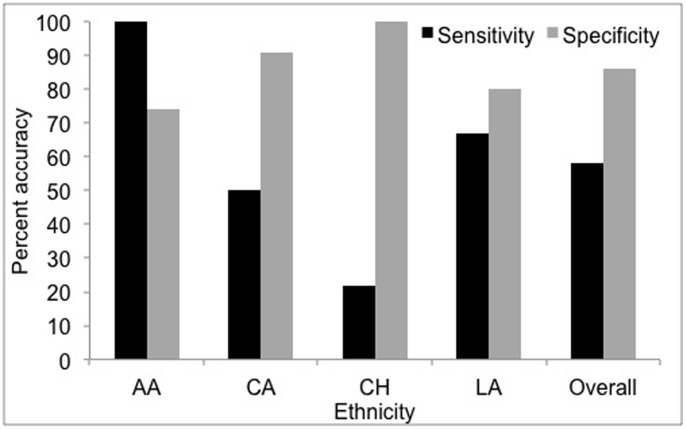
Accuracy of discriminating between ethnicity using the subgingival microbial signature.Non-Hispanic Blacks (AA) demonstrated the greatest accuracy, with 100% sensitivity and 74% specificity, followed by Latinos(LA) and Caucasians (CA).